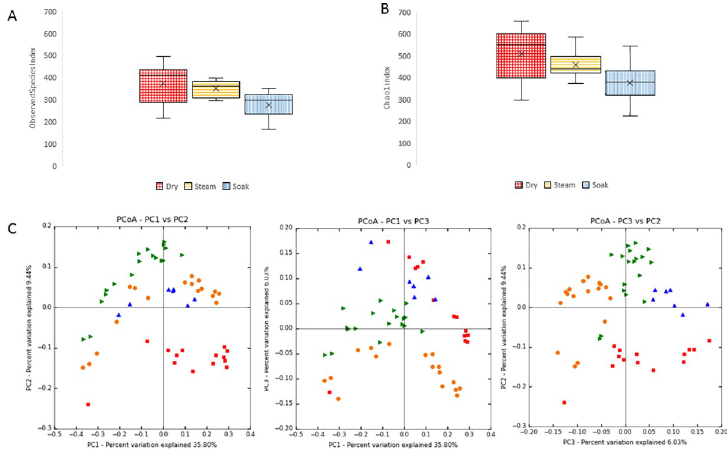
Fig 7. Effect of regimens on diversity, (A) Observed species (B) Chao1, 5000 seqs per sample, W (n = 11) hay was less diverse than D (n = 10) & HTS (n = 9). (C) Beta diversity between regimens PCoA loadings plots of unweighted unifrac D (n = 10), W (n = 11) and HTS (n = 9).